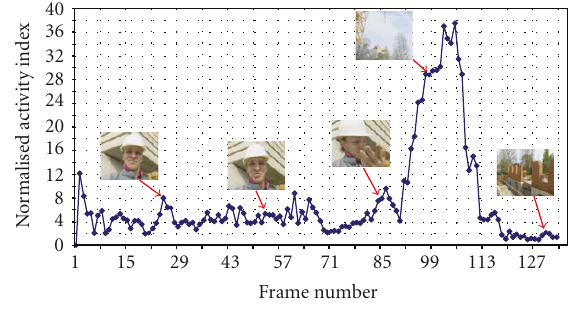
Figure 3: NAI computation for the “Foreman” stream.